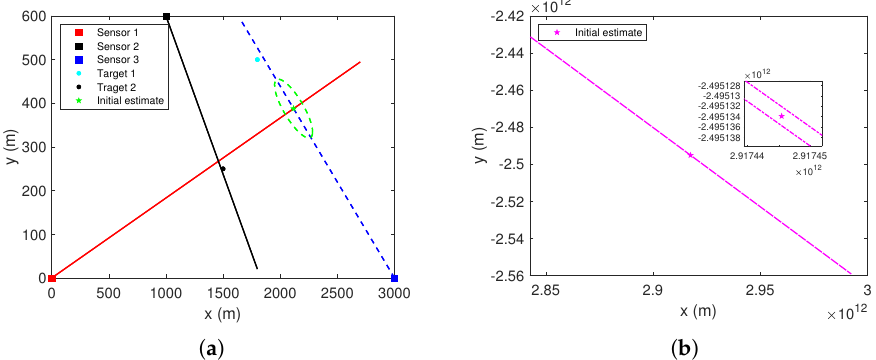
. ( b ) z 121 . ( c ) z 122 . ( d ) z 211 . ( e ) z 221 . ( f ) z 222 . k k k k k k